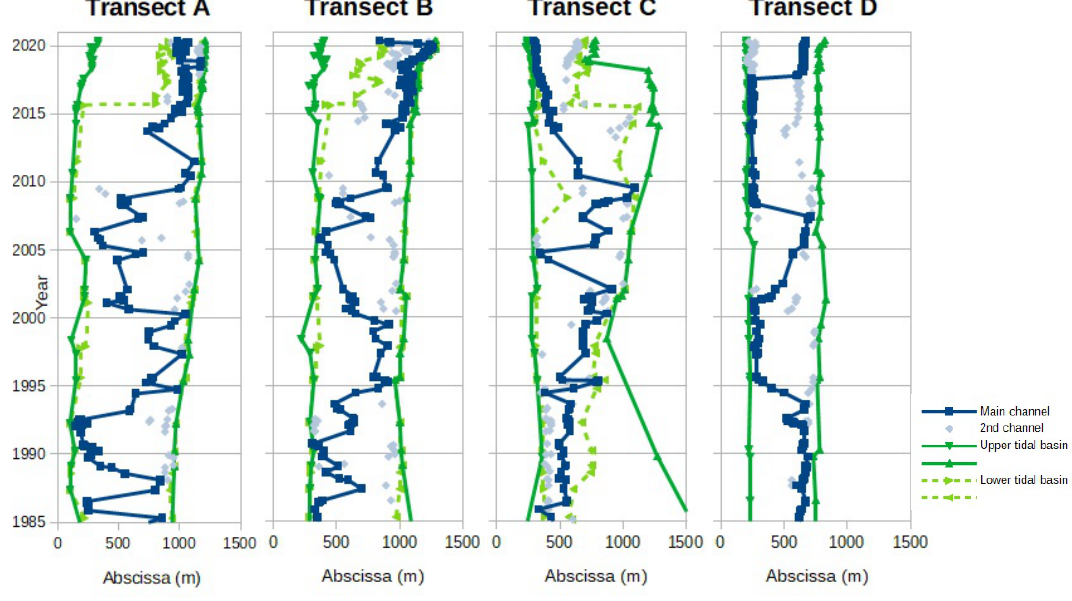
Figure 12. Chronicles of the Authie meanders from 1985 to 2020 along transects A to